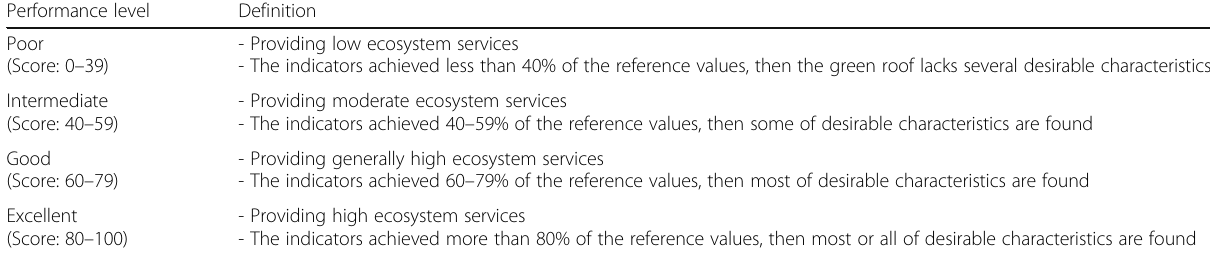
Table 3 Assignment of performance levels of ecosystem service